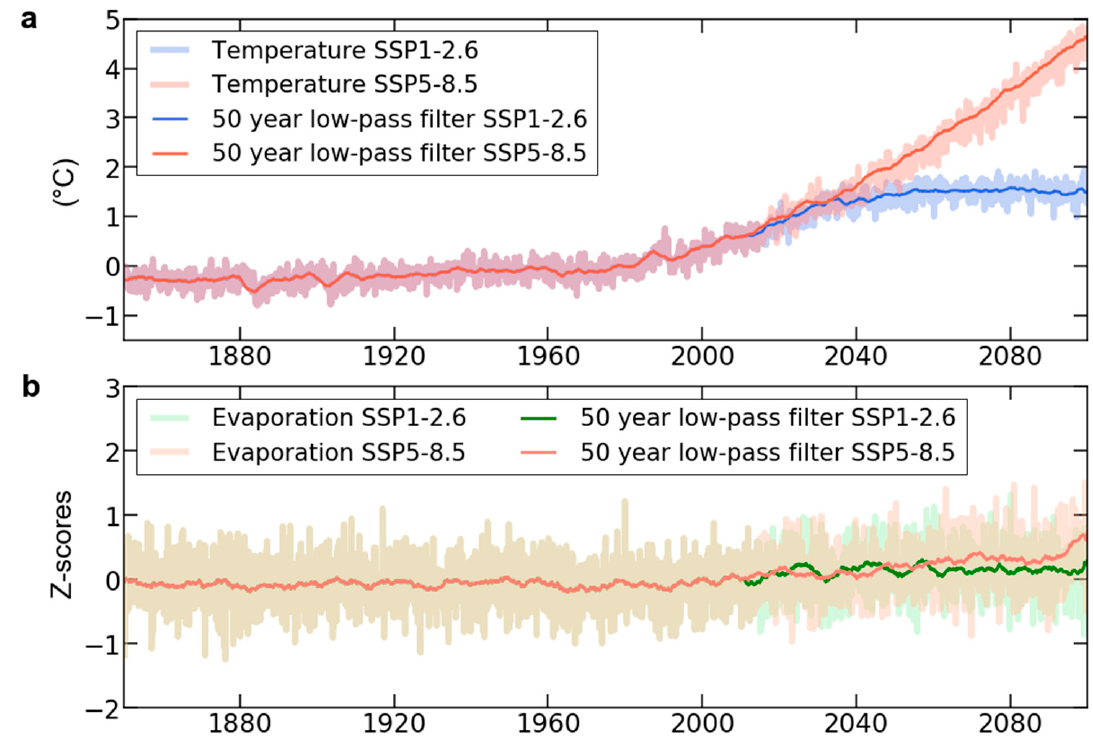
Figure 4. Multimodel means of projected changes in temperature and evaporation. ( a ) Trends of temperature following the SSP1-2.6 and SSP5-8.5 warming scenarios. ( b ) as in (a) but for evaporation. For display purposes, for each climate variable, we appended historical simulations (1850–2015) to each of the projected simulations following the SSP1-2.6 and SSP5-8.5 warming scenarios